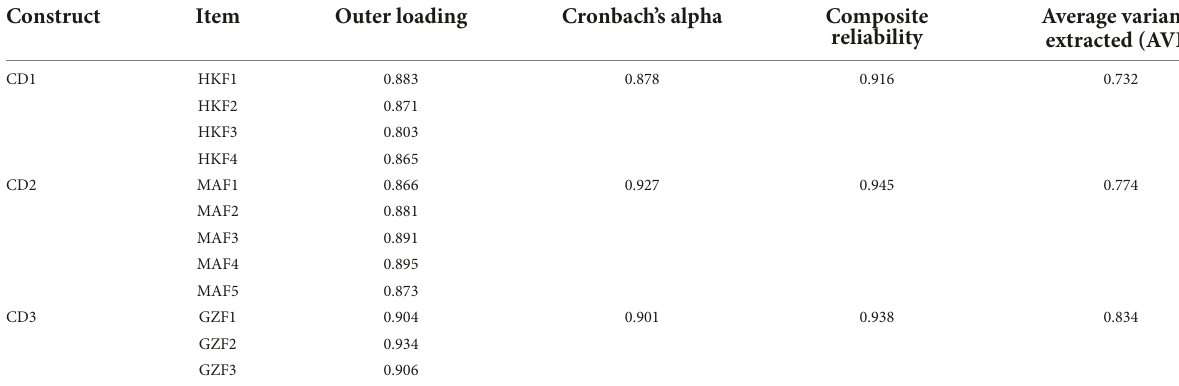
TABLE 5 Reliability and validity for second-order constructs.